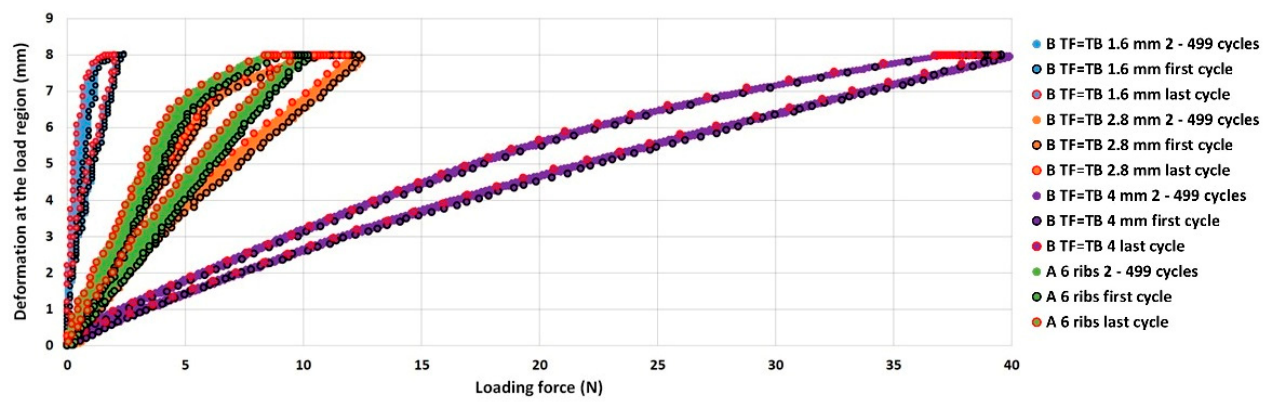
Figure 17. Cyclic hysteresis for tested structures B and structure A with 6 ribs.